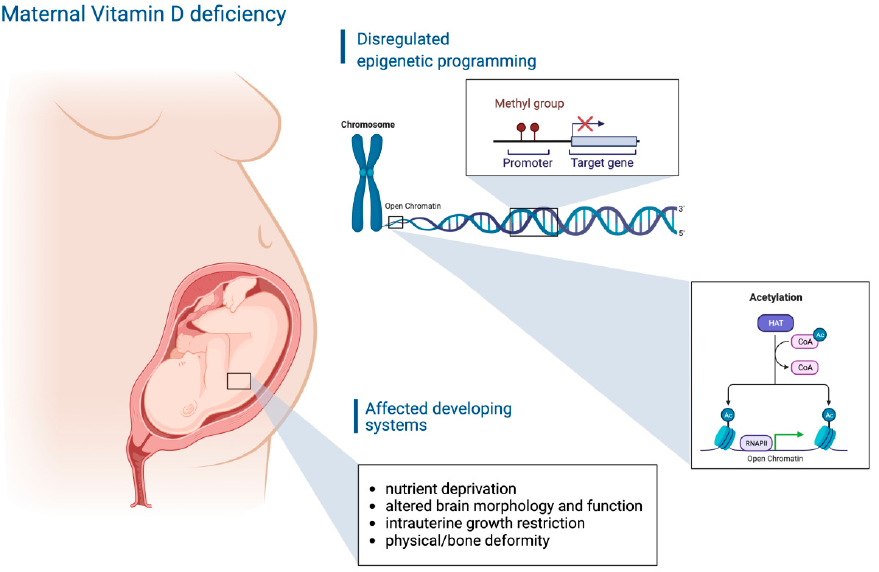
Figure 2. Scheme showing the outcome of maternal vitamin D deficiency on the developing fetus. Based on a dysregulated epigenetic reprogramming and VD deficiency, several organ systems of the offspring can be affected [48].